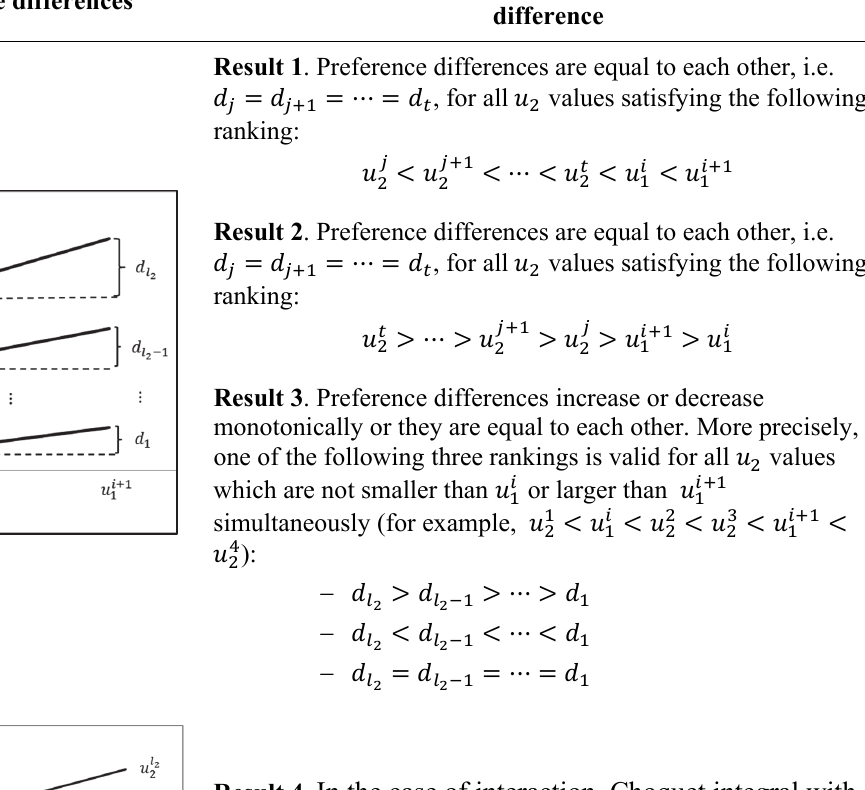
Result 4. In the case of interaction, Choquet integral with respect to unipolar capacity produces a piecewise linear function for criterion 1 for each level of criterion 2. The break point occurs at the level of criterion 2. The adjacent figure illustrates this result for the ranking given